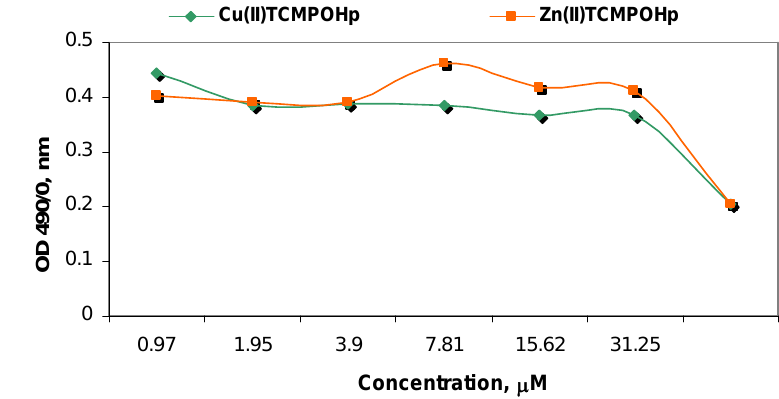
Figure 3. The viability of HT29 cells incubated 2h ( a ) and 24h ( b ) with Zn(II)TCMPOHp and Cu(II)TCMPOHp; the LDH release registered as OD at 490